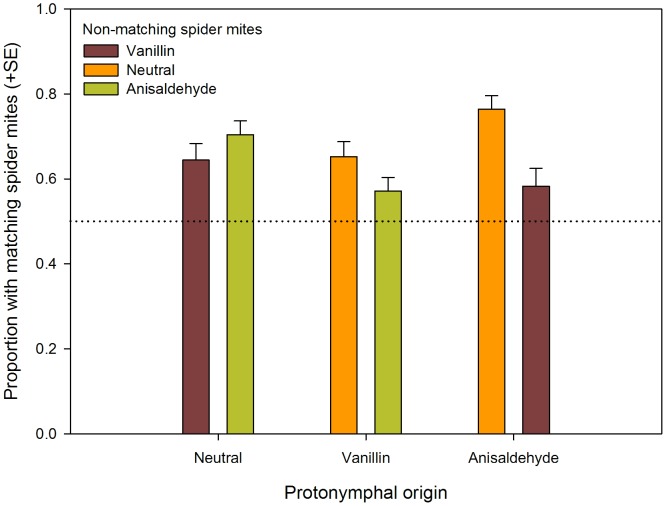
The effects of prenatal learning on residence preference of predatory mite protonymphs.Mean (± SE) proportion of N. californicus protonymphs preferentially residing in the vicinity of spider mites matching the type in their maternal diet. Protonymphs originated from mothers fed on neutral, vanillin- or anisaldehyde-flavored spider mites and were given a binary choice between dead spider mites matching the maternal diet and non-matching spider mites (n = 24 for each of the six choice situations).